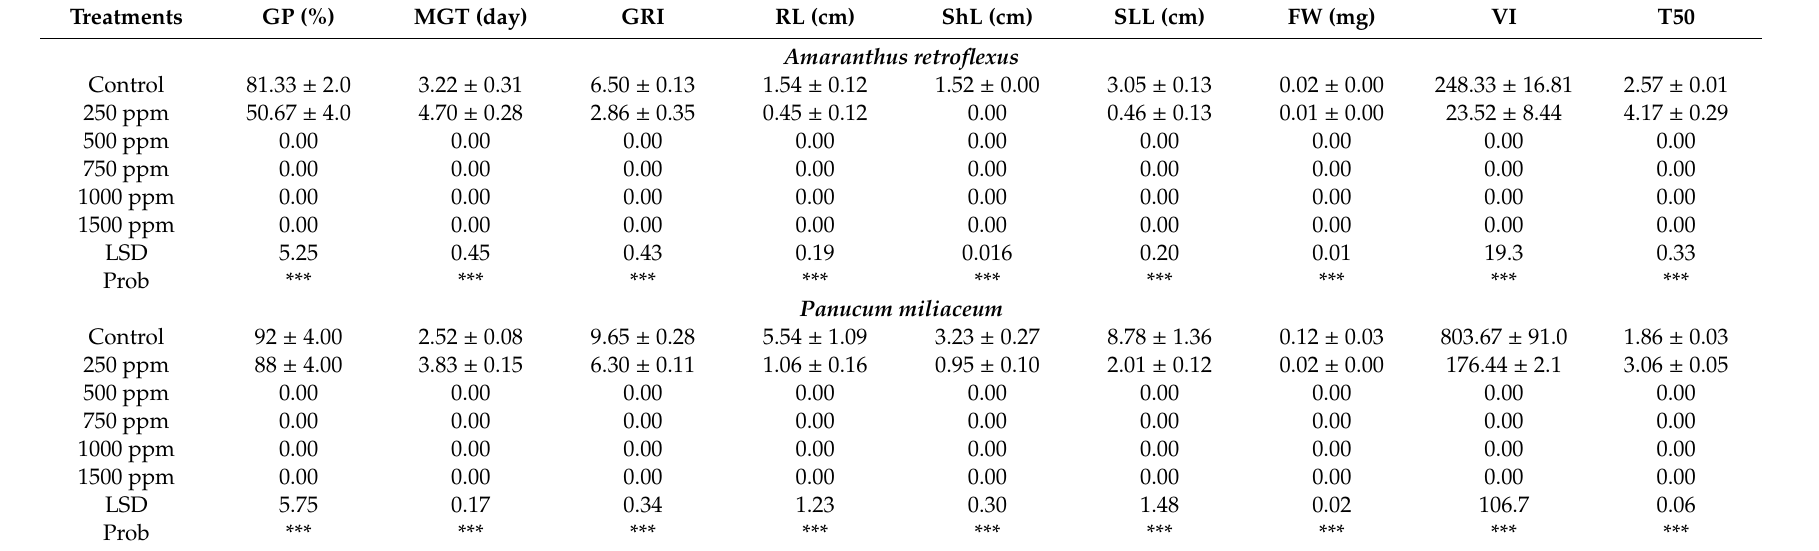
Table 2. Influence of various concentrations of T. kotschyanus essential oil in seed germination indices of A. retroflexus and P. miliaceum at the end of incubation time. GP: germination percentage, MGT: mean germination time, GRI: germination rate index, RL: root length, ShL: shoot length, SLL: seedling length, FW: fresh weight, VI: vigor index, and T50: the time to reach 50%